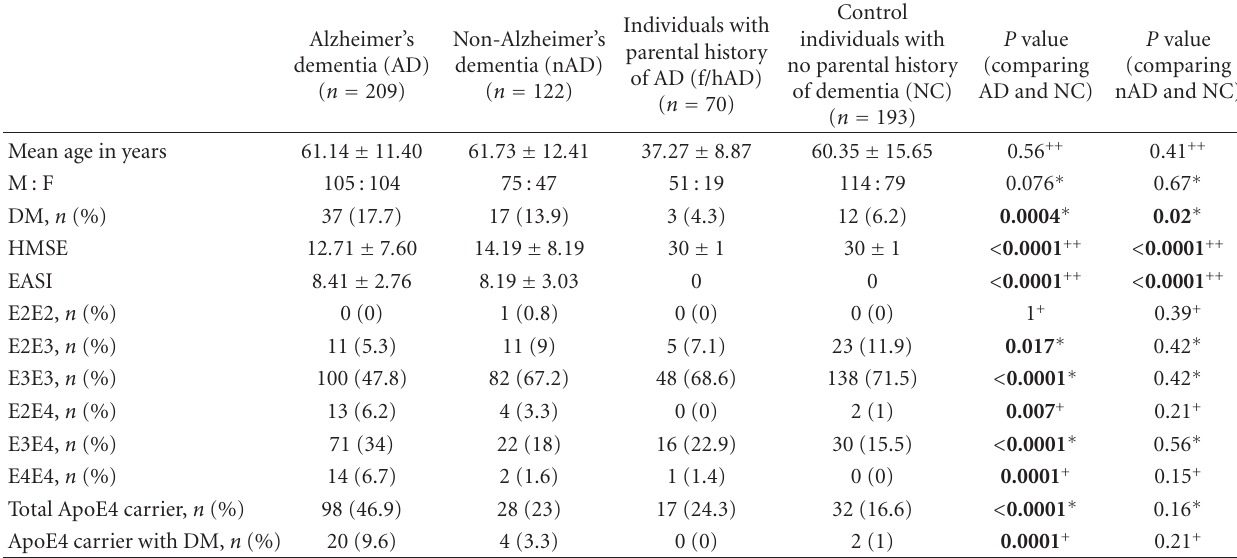
Table 1: Clinical profile and ApoE polymorphism in the study population.